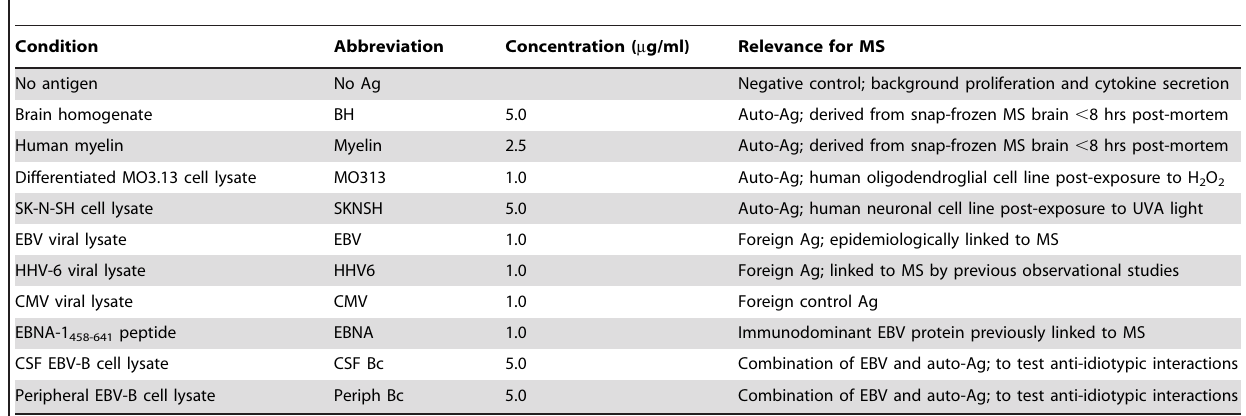
Table 2. Classification of candidate